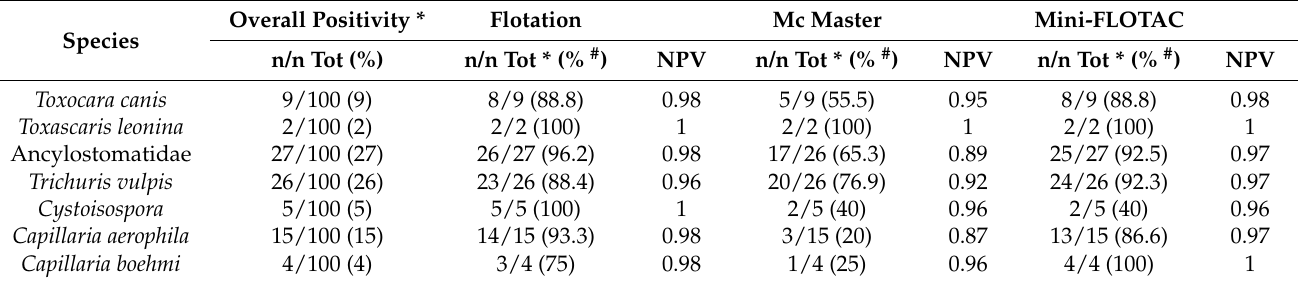
Table 2. Number (n) and percentage (%) of dog fecal samples that scored positive using each technique compared to the overall positivity to a given parasite (n tot), to obtain the sensitivity of each technique for each parasite.